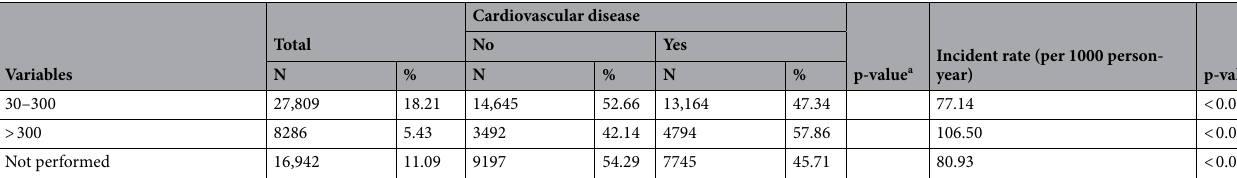
Table 2. The incident rate of cardiovascular disease in patients with T2DM. a Log-rank test. b